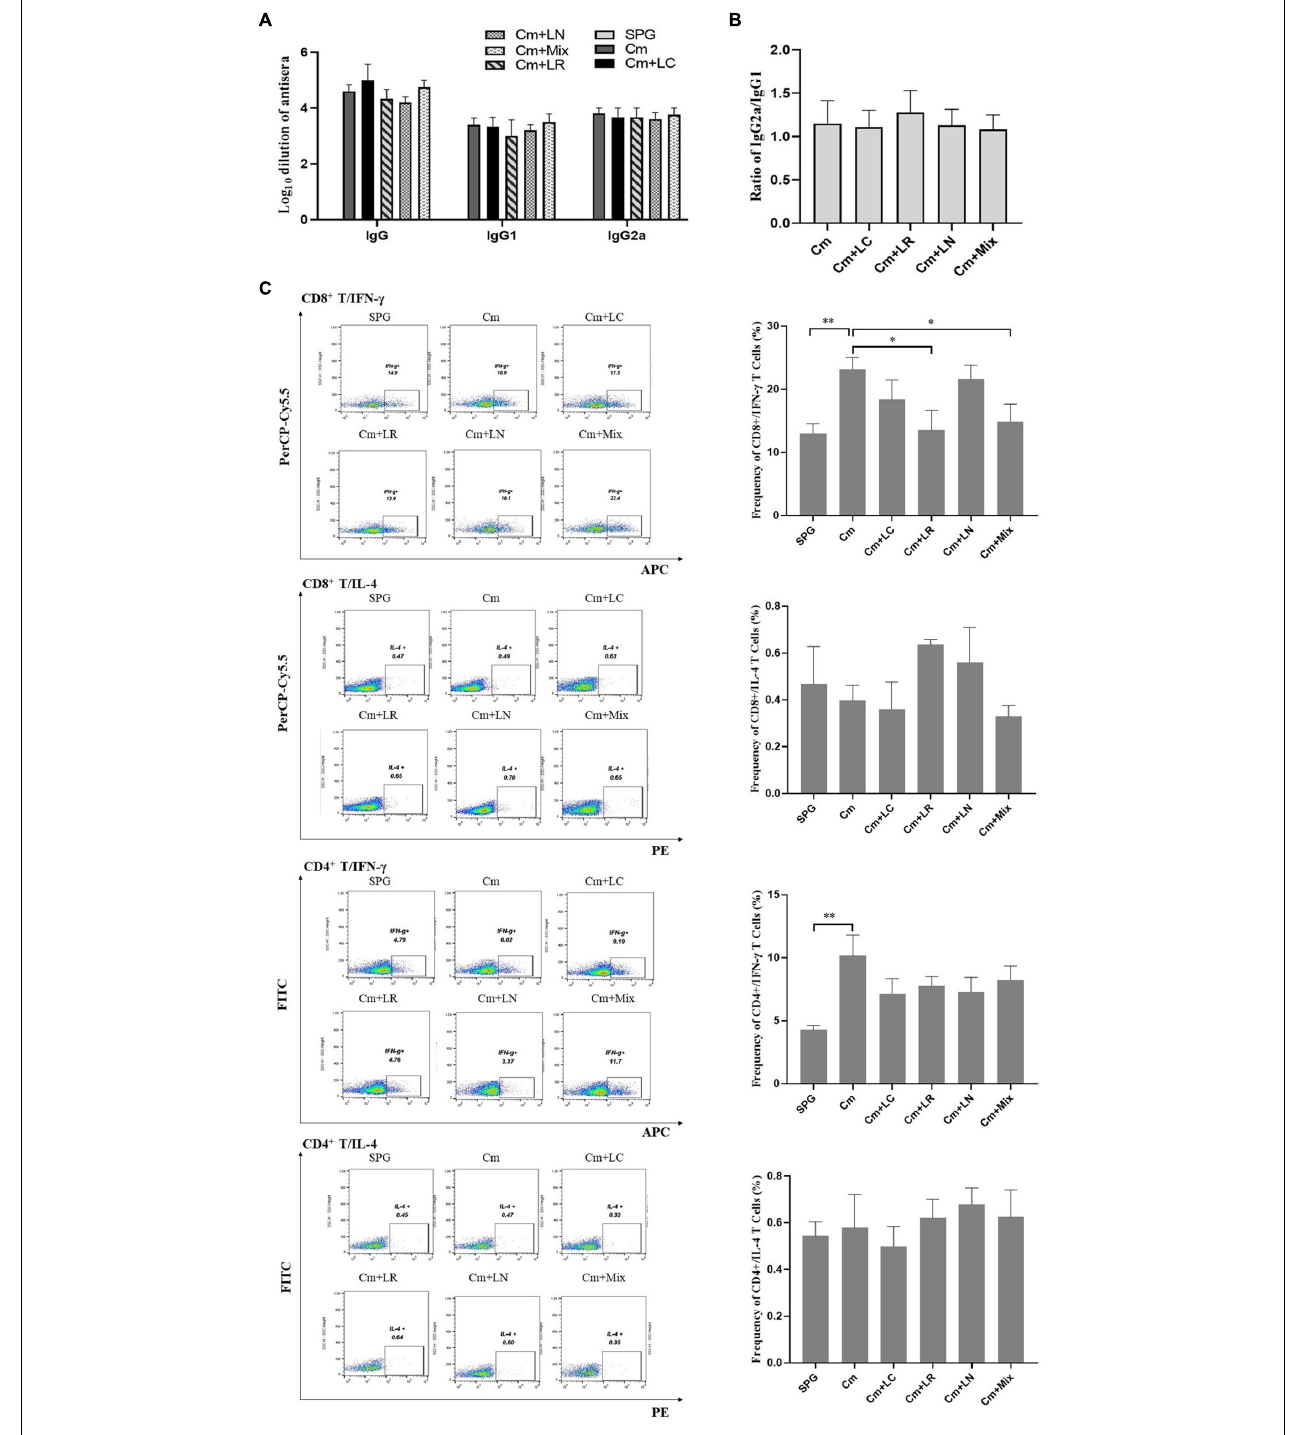
FIGURE 7 | Effects of lactobacillus intravaginal administration on the switch of chlamydia-mediated immune responses, following intravaginal infection with C. muridarum . On Day 80 after infection, mouse sera from the six groups of the mice were collected to measure the titers of chlamydia-specific total IgG Abs and IgG in different isotypes (A) . A 10-fold serially dilutions of the mouse sera were carried out, starting with 1:10; the Ab titers of which were expressed as log10 dilution. (B) The ratio of IgG2a versus IgG1 from each group of mice was calculated (inapplicable for the SPG group). (C) Spleens were harvested from each mouse at Day 80, and 2- × − 10 6 splenocytes were cultured with a cell stimulation cocktail at 37 ◦ C for 6 h. Following stimulation, intracellular IL-4 and IFN- γ staining was carried out and determined by flow cytometry as detailed in section “Materials and Methods.” Frequency of CD8 + /IFN- γ , CD8 + /IL-4, CD4 + /IFN- γ , and CD4 + /IL-4 cells was calculated according to intracellular flow cytometry staining. Results from an independent sample. ∗ p < 0.05 and ∗∗ p < 0.01 (one-way ANOVA).